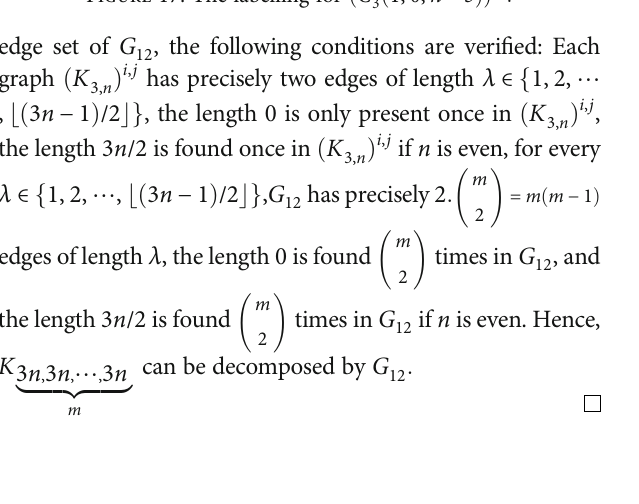
Figure 17: The labelling for ð C